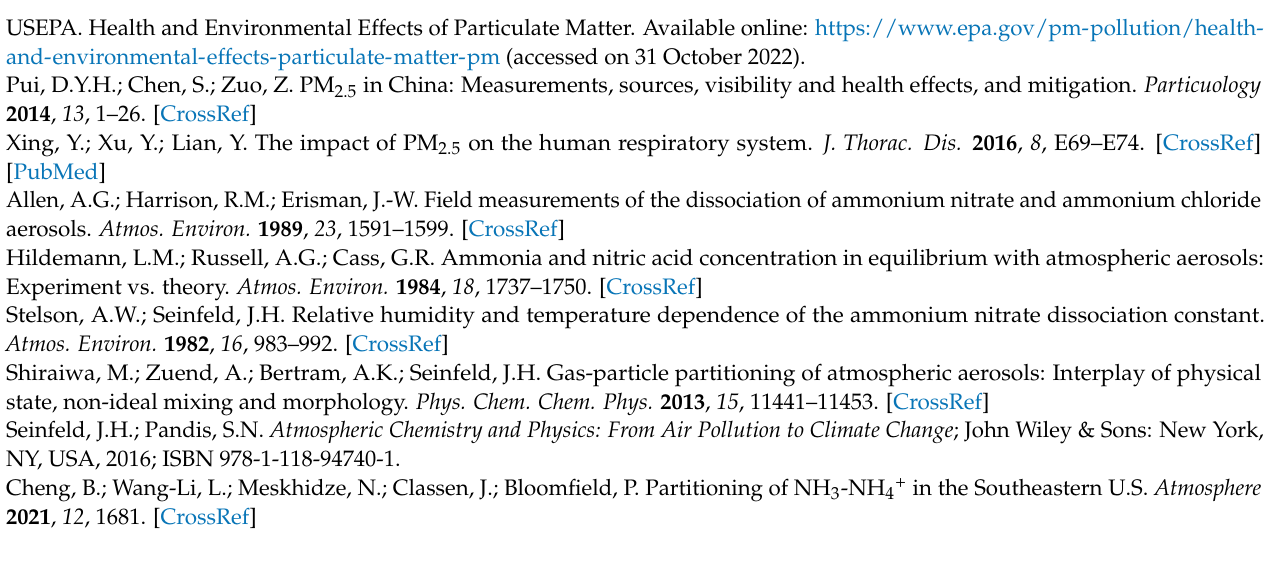
Table S5: Model performance assessment for iPM2.5 prediction with stable and metastable setups at the YRK site; Table S6: Factorial ANOVA test results at the YRK site; Table S7: Model performance of ISORROPIA II at the YRK